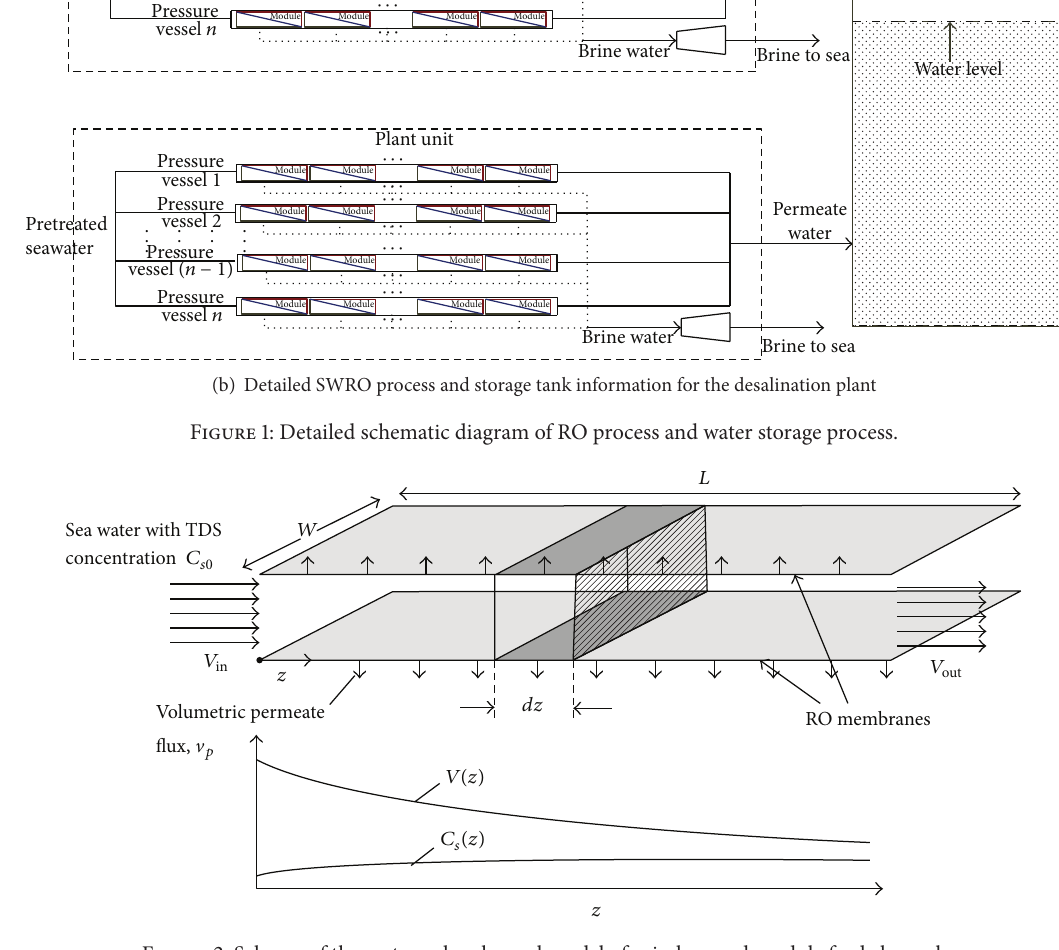
Figure 2: Scheme of the rectangular channel model of spiral wound module feed